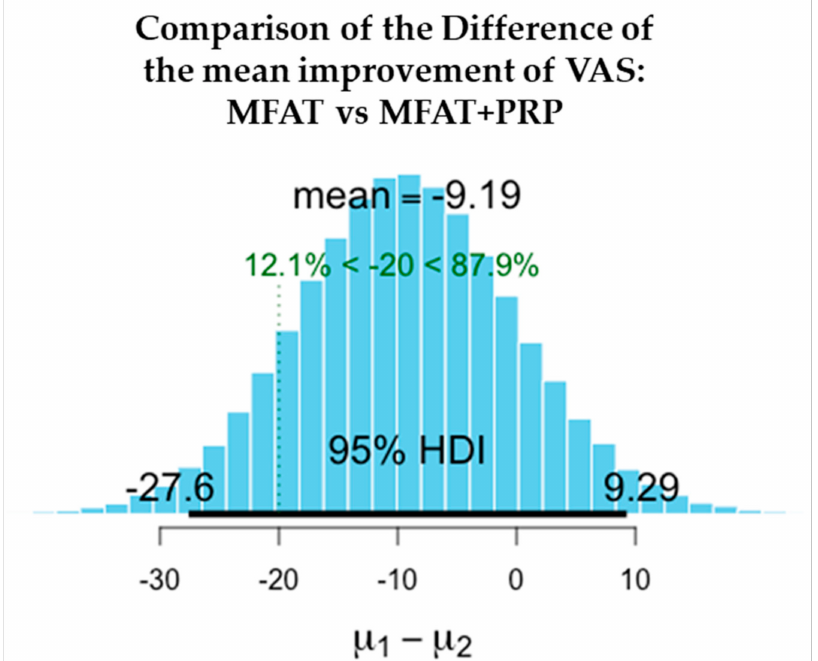
Figure 10. This demonstrates the difference between the change in VAS in MFAT only and MFAT + PRP treatments. ( µ 1 ): The difference in VAS following treatment by MFAT only (VAS at one year–Index VAS); ( µ 2 ) the difference in VAS following treatment by MFAT + PRP (VAS at one year–index VAS).